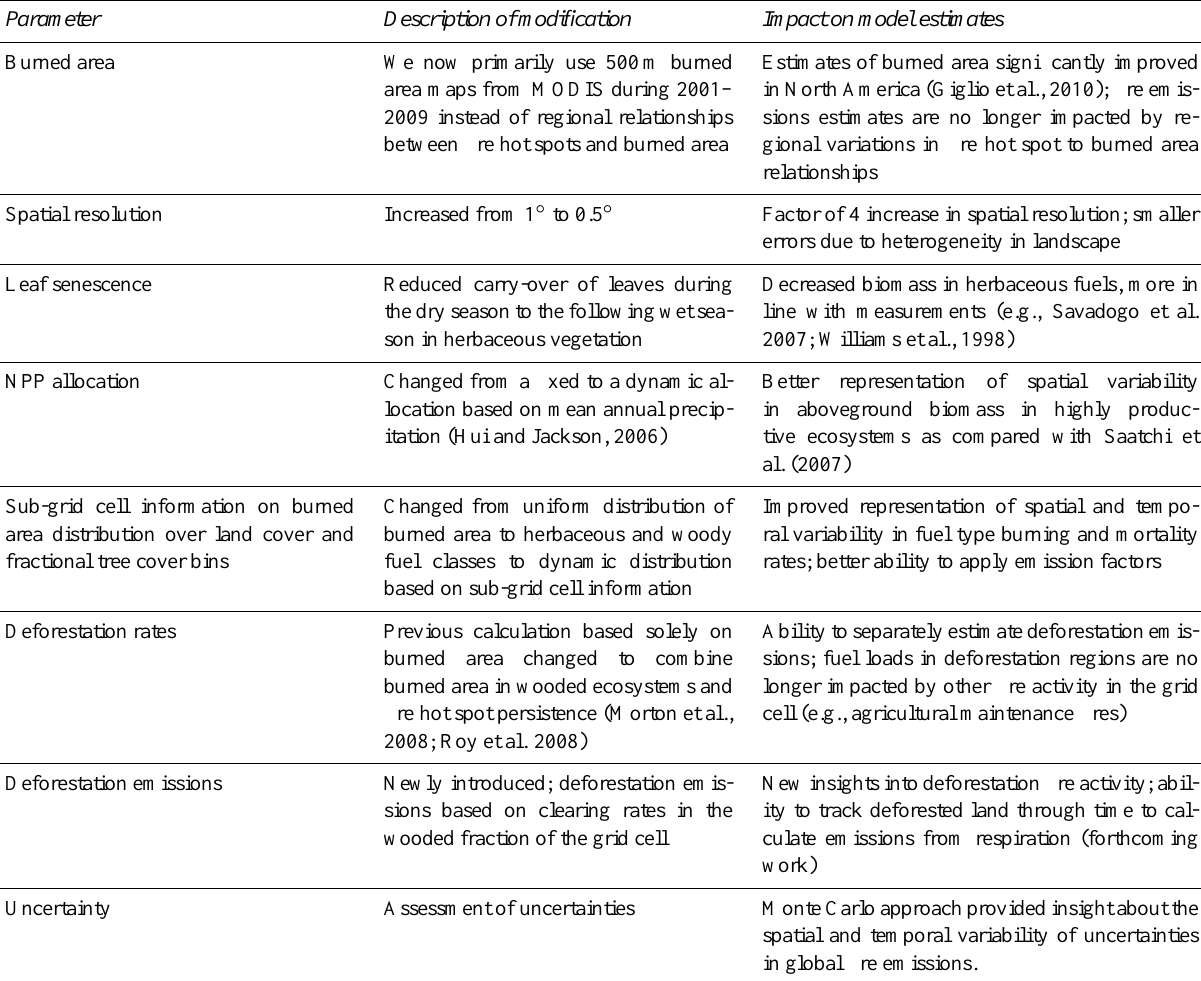
Table 3. Improvements in biogeochemical modeling framework for